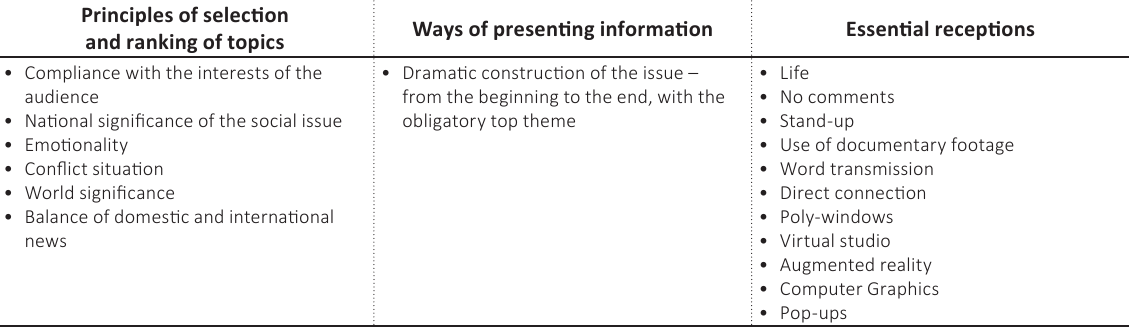
Table 4. Structural model of social television Principles of selection and ranking of